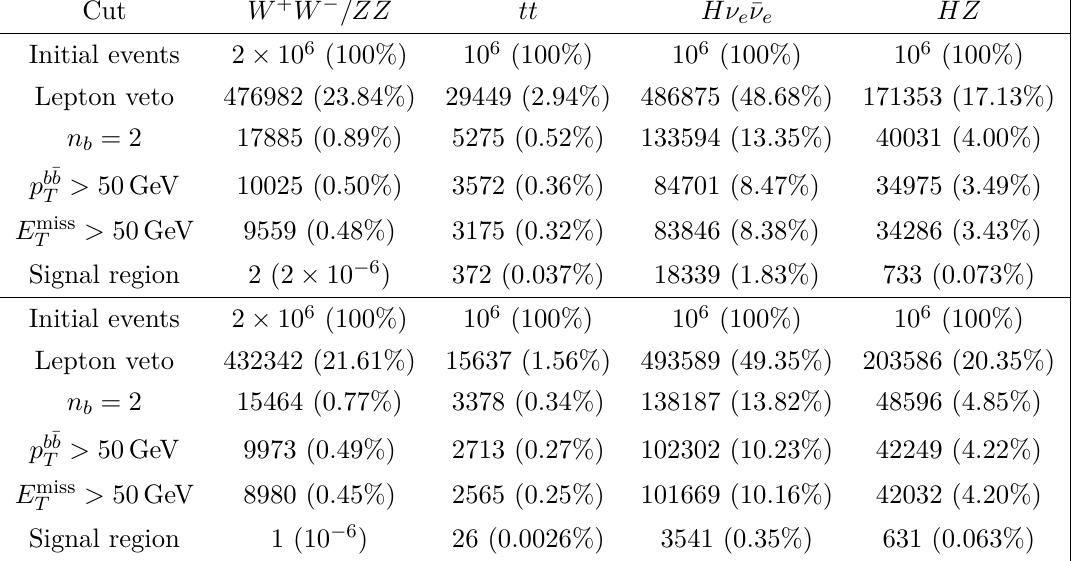
Table 2 . The cutflow table for various background contributions after each selection step. We show √ the cases s = 500 GeV (upper panels) and parentheses show the efficiency after the selection step i which is defined as (cid:15) = n the initial number of